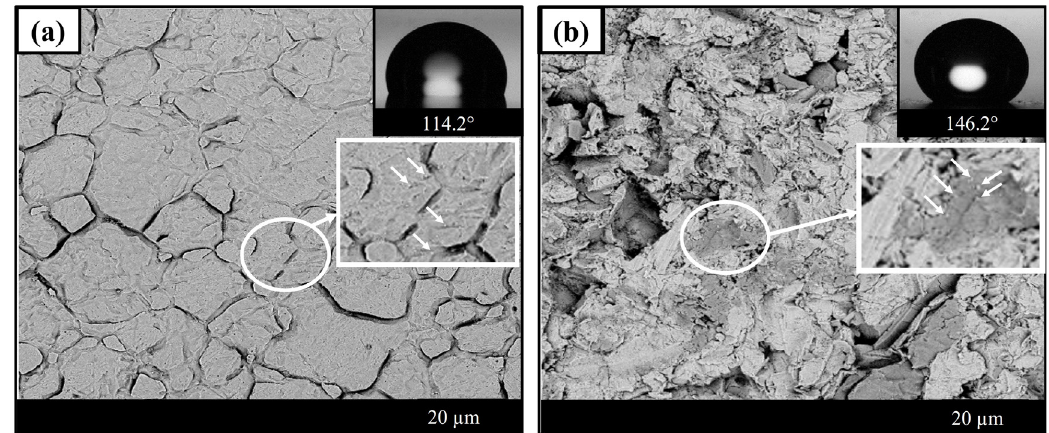
Figure 3. Top-view SEM micrographs and contact angle of the stainless-steel substrate with a smooth (a) and sandblasted surface (b) with a stearic acid (SA) coating.